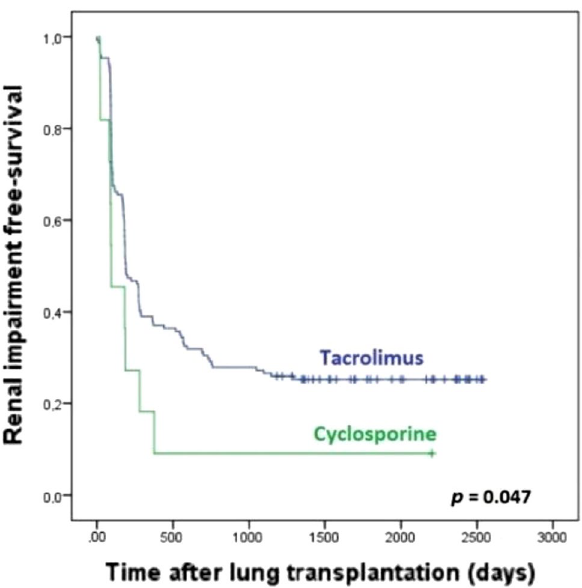
Figure 2. Development of renal impairment according to the CNI drug prescribed in our cohort of LTRs in the post-transplantation